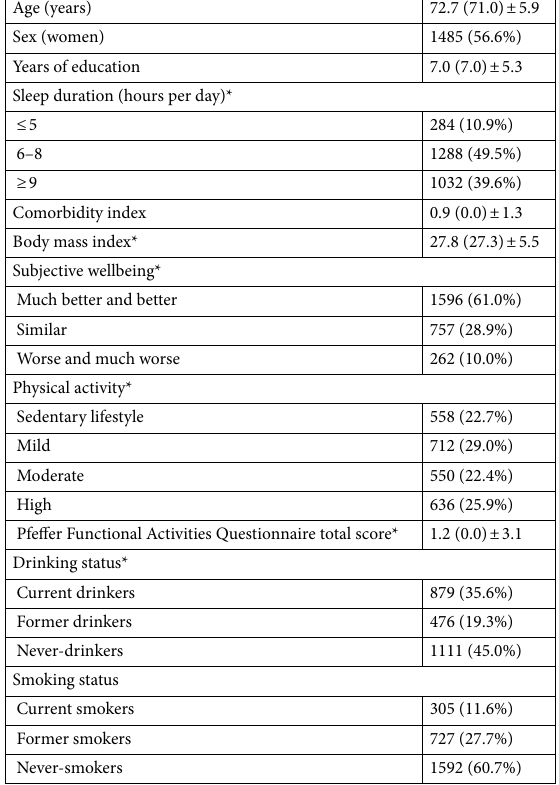
Table 1. Baseline demographic and clinical characteristics of participants (N = 2624). Mean (median) ± standard deviation and frequency (%) are reported. *Data on some participants were